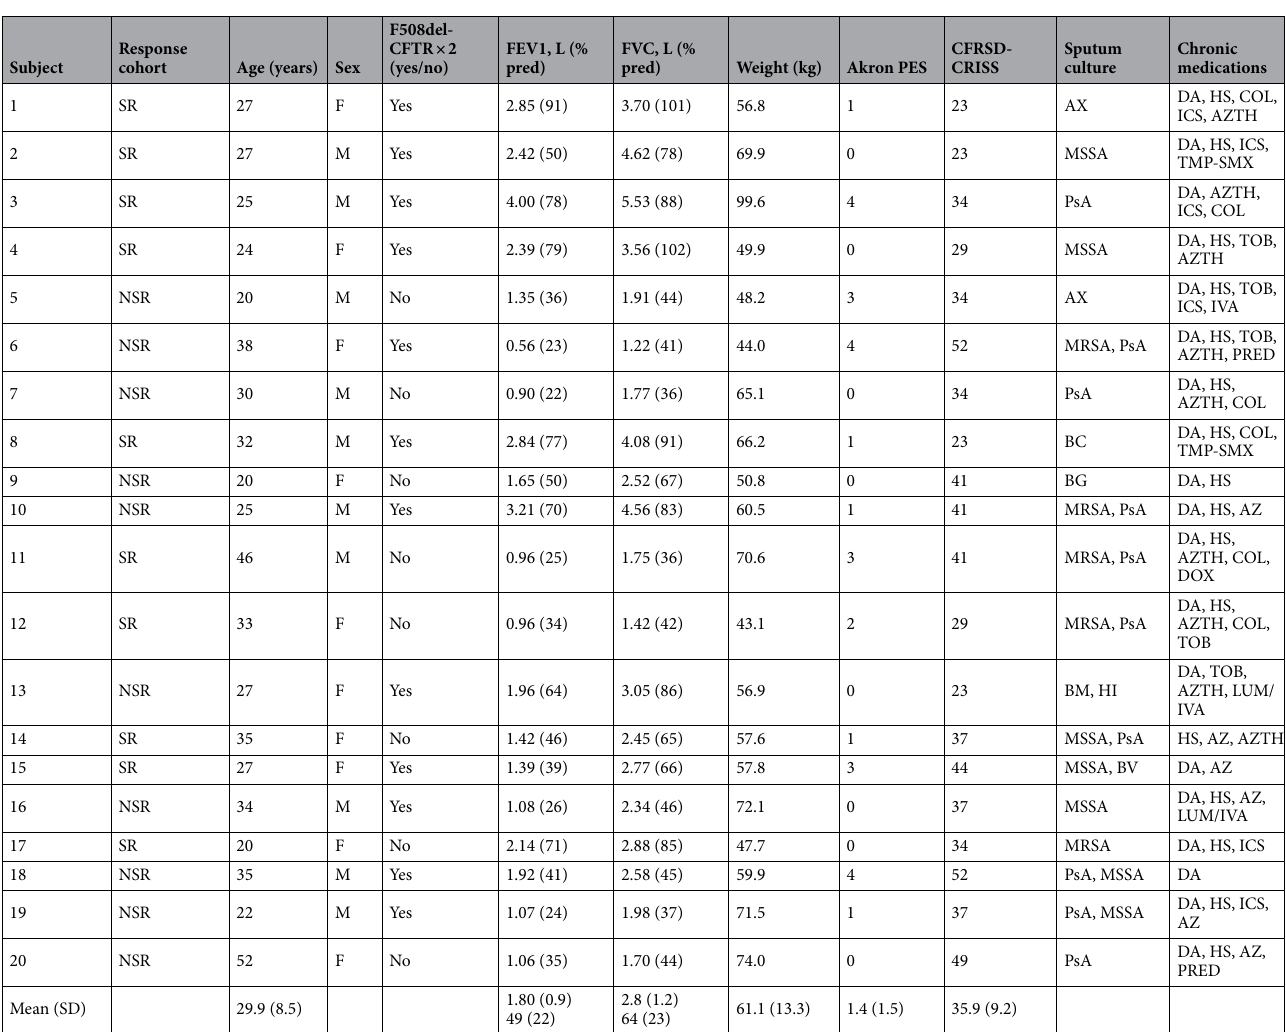
Table 1. Baseline clinical characteristics of the study population prior to PEX onset. F508del × 2 = F508del- CFTR homozygote; PES = Pulmonary Exacerbation Score; CFRSD-CRISS = CF Respiratory